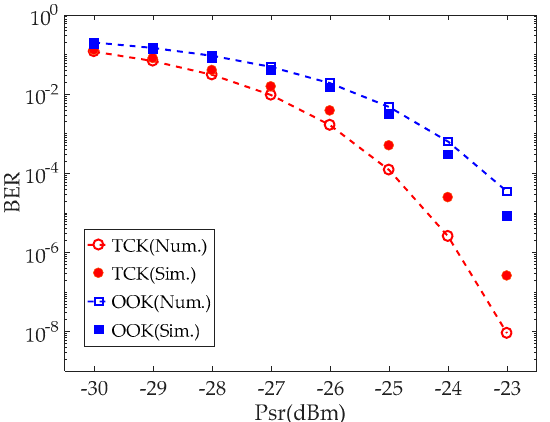
Figure 7. Bit-error rate (BER) versus the effective power of light source P sr for an OOK and TCK packet. Num.: numerical analysis; Sim.: simulation.